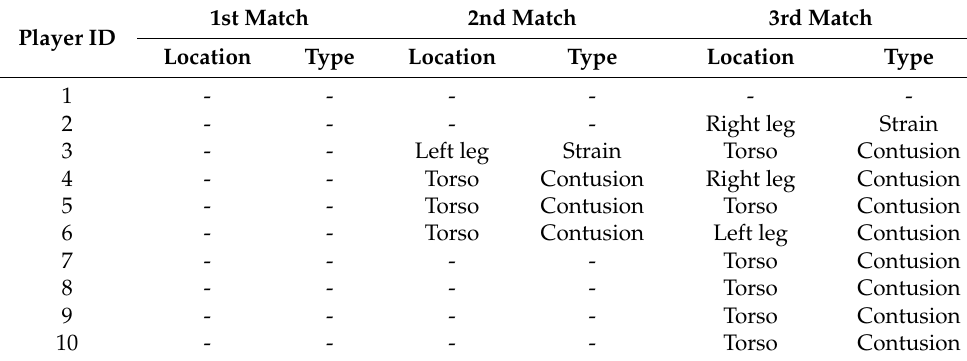
Table 2. Incidence and injury type by